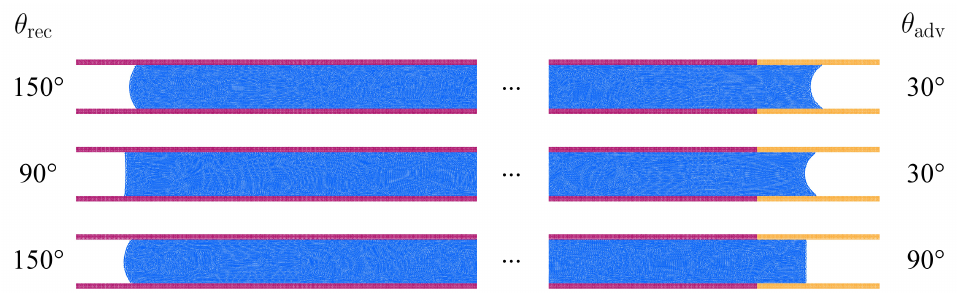
Figure 13. Variation of advancing and receding contact angle for flow between parallel